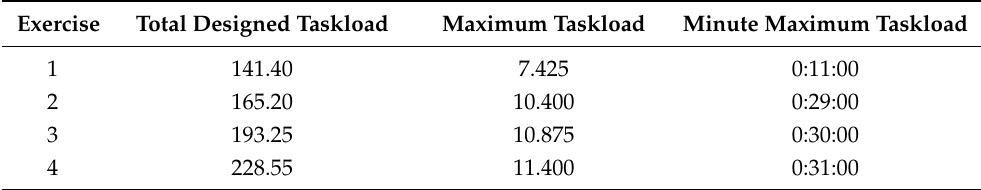
Table 1. Comparison of the designed values of the four exercises in the simulation program.